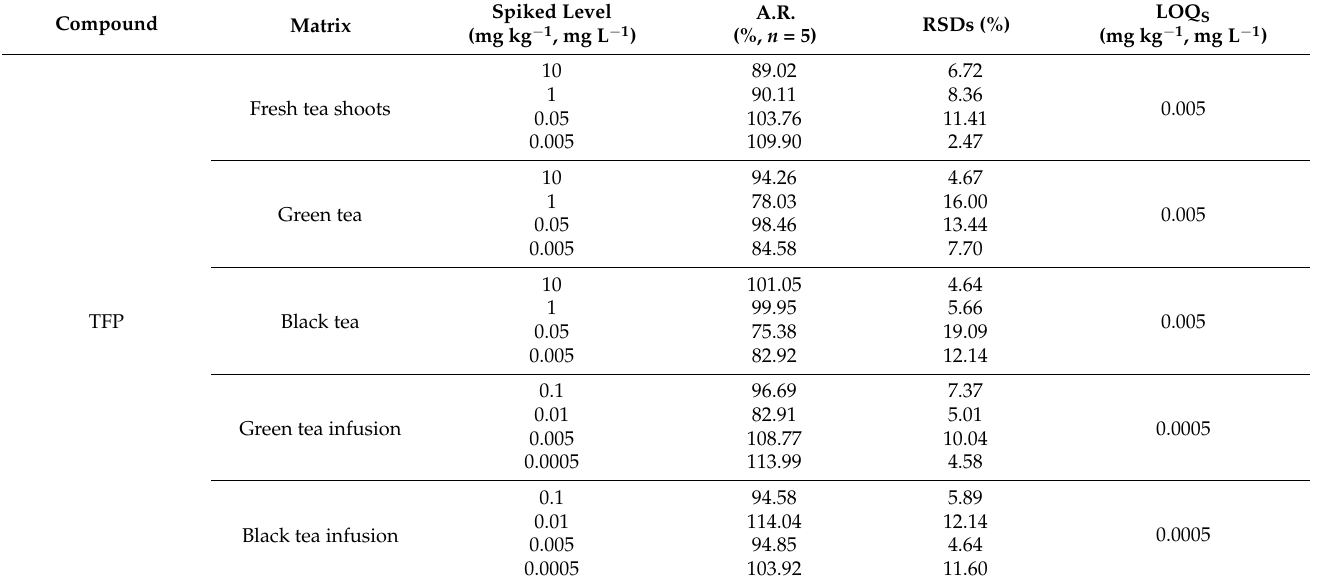
Table 4. The average recoveries (A.R.), relative standard deviations (RSDs) and limits of quantification (LOQs) of TFP and its